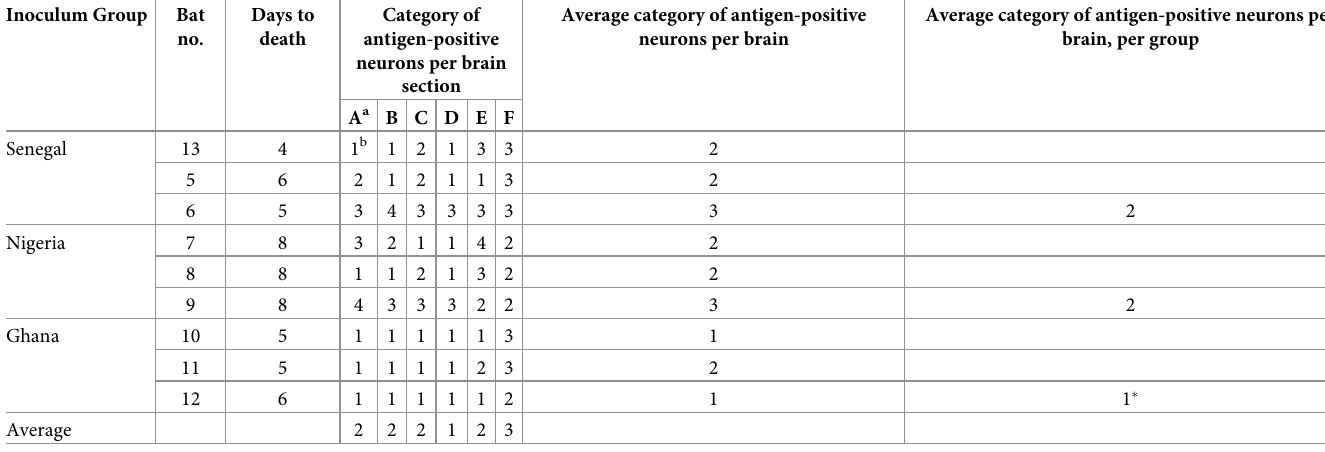
Table 3. Distribution of Lagos bat virus antigen in the brains of experimentally infected bats. Inoculum Group Bat